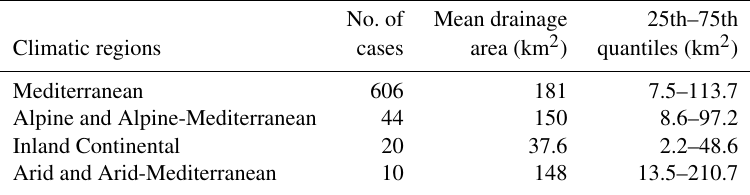
Table 2. Summary statistics for drainage areas for the EuroMedeFF database under different climatic regions.